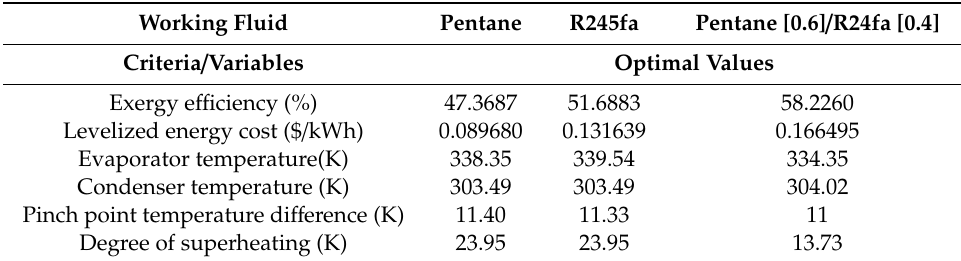
Table 5. The detail information about the best possible solutions for di ff erent working fluids. Working